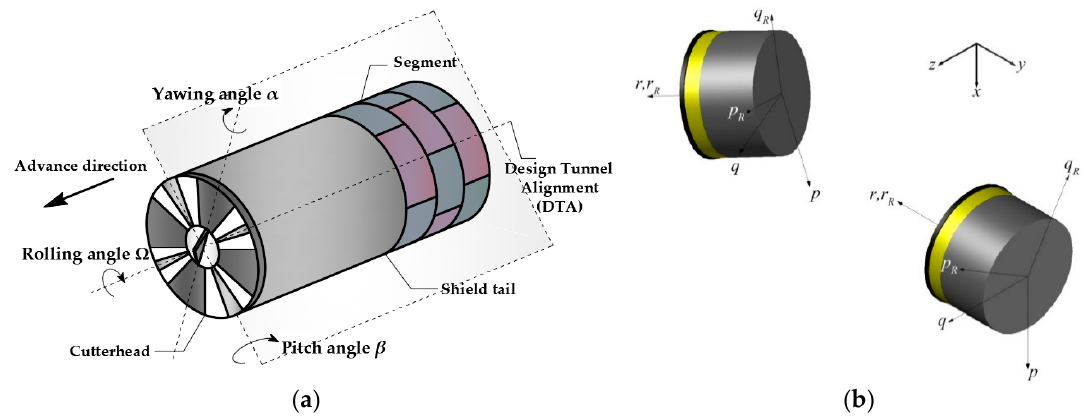
Figure 2. Attitude angles and coordinate system: ( a ) attitude angles; and ( b ) coordinate system.